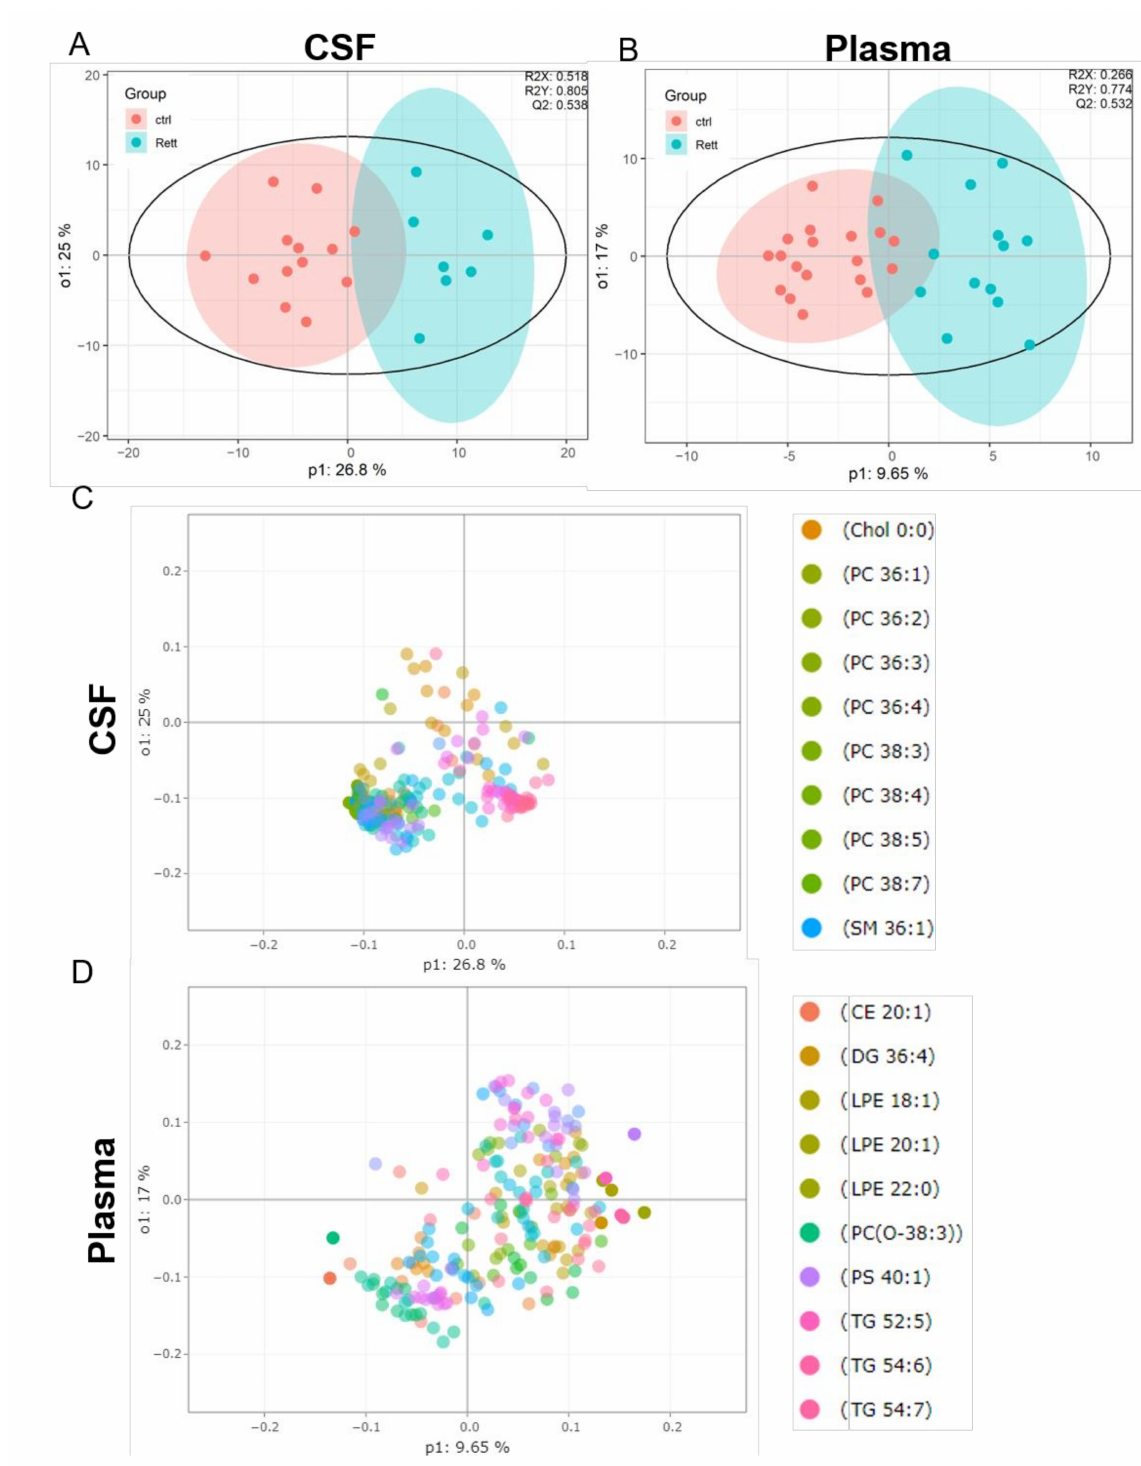
Figure 2. Supervised multivariate statistical analysis of the CSF ( A , C ) and plasma ( B , D ). ( A , B ) Orthog- onal partial least square-discriminant analysis (OPLS-DA) plots were generated using the lipidome data set obtained from UHPLC-MS/MS analysis and the program R with the lipidr package. ( C , D ) Loading plot of CSF ( C ) and plasma ( D ) samples obtained from RTT patients compared to healthy con- trols. Scattered dots represent various lipid species that were identified as influential variables in the discriminant analysis. The top 10 variables are listed in the right panel. CE (Cholesterol Ester), Chol (Cholesterol), DG (Diacylglycerol), PC (Phosphatidylcholine), LPE (Lyso-Phosphatidylethanolamine), PS (Phosphatidylserine), SM (Sphingomyelin), TG